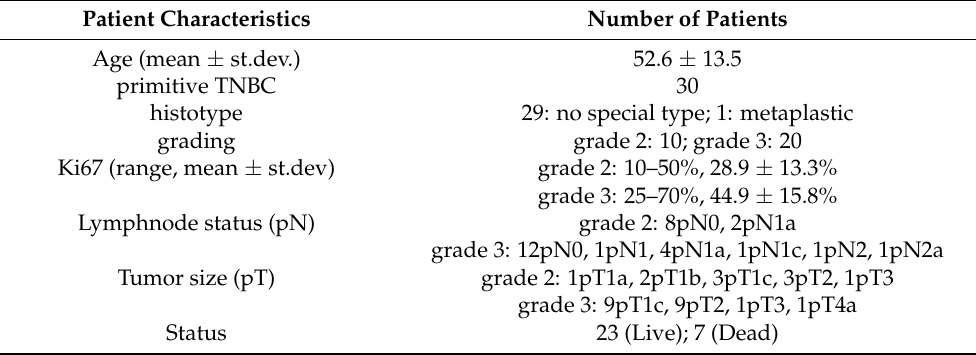
Table 1. Clinic-pathological assessment of